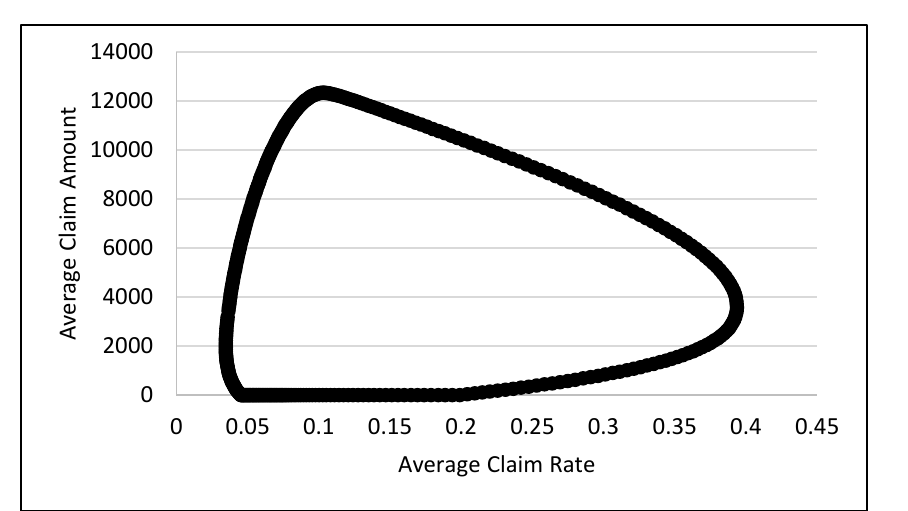
Fig. 2. The 28th prediction region for (𝑃 𝑐 , 𝐶 𝑎 ) [𝐾 = 1, 𝑍 = 1,𝐵 = 4,𝑀 = 1]